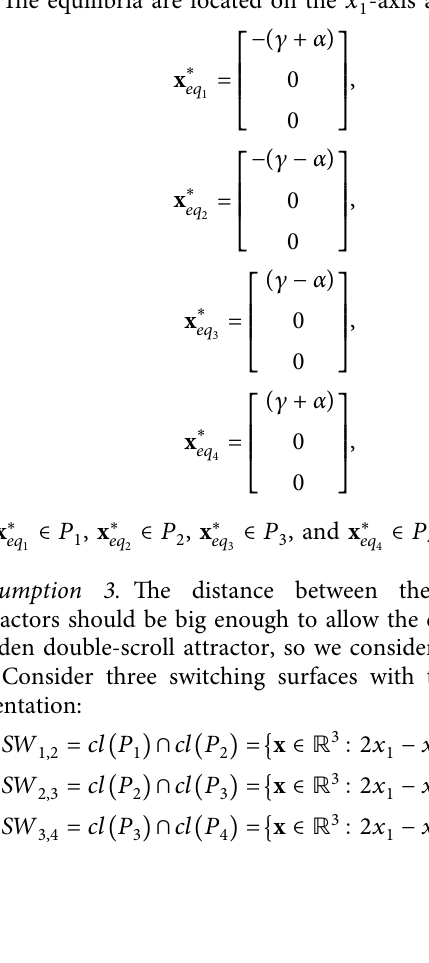
Figure 1: In (a) the heteroclinic loop of system (1), (2), (4), and (5) with the switching surface x ∈ R 3 : 2 x a � 0 . 2 ,b � 5 , c � − 3 , α � 1 and in (b) a double-scroll attractor that emerges from an heteroclinic loop using the following initial condition � ( 0 , 0 , 0 ) T x 0